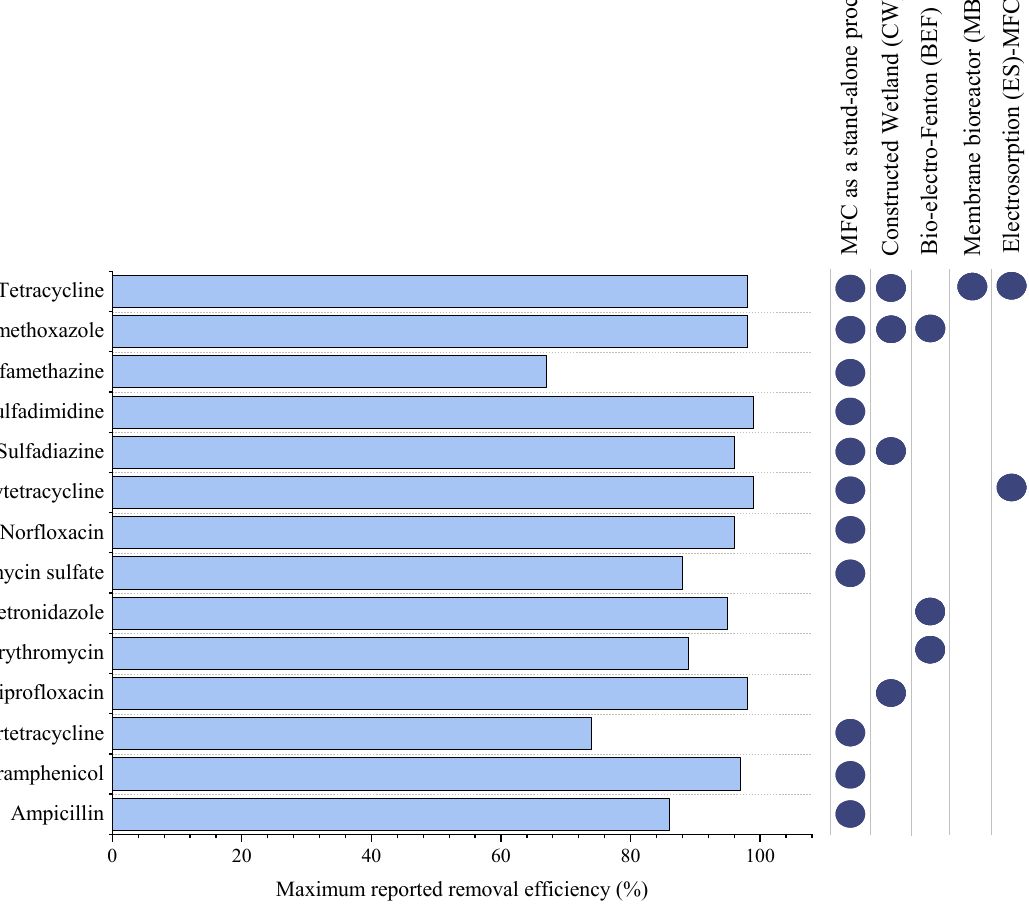
Figure 6. Maximum reported removal efficiencies of different antibiotics and corresponding microbial electrochemical systems used for treatment (based on the references shown in Tables 1–3).